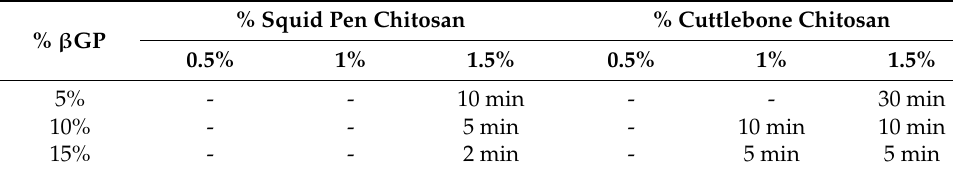
Table 3. Thermal gelation of chitosan solutions with beta glycerol phosphate at 37 °C.